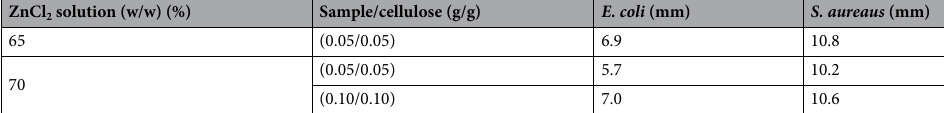
ZnCl 2 solution (w/w)